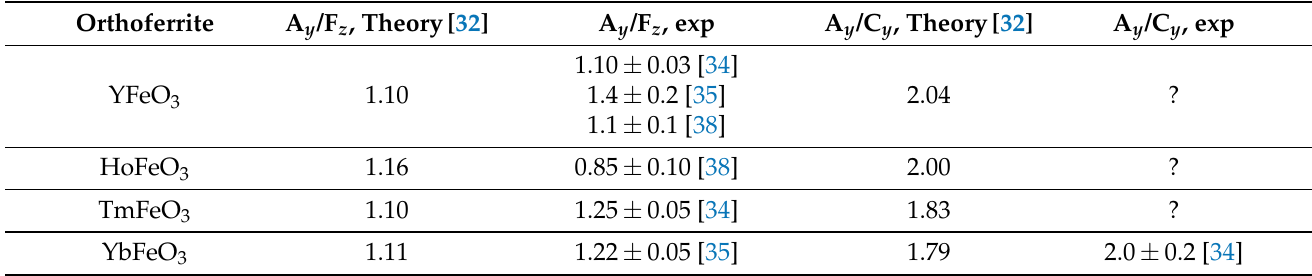
Table 4. Hidden canting in